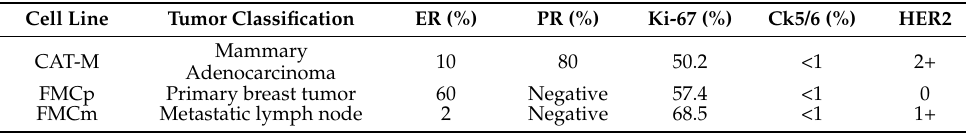
Figure 3. The HER2 pathway is a common target in human breast cancer therapy, revealing promising results for the treatment of cats with mammary tumors. Table 2. Classification and molecular characterization of FMC cell lines [10,11].